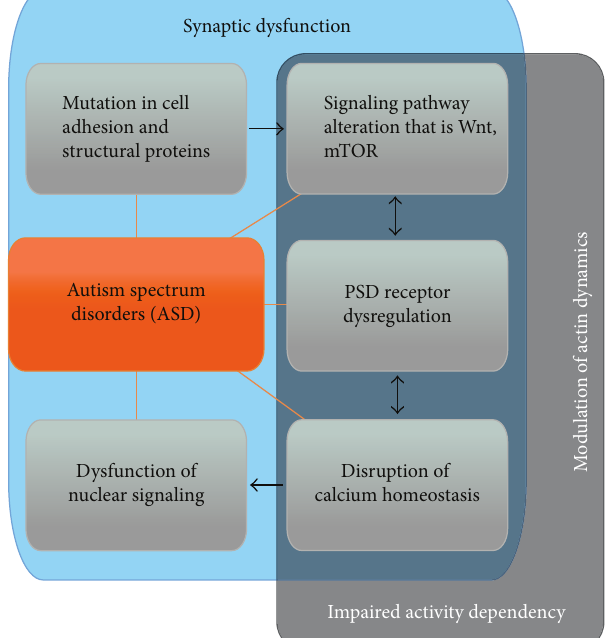
Figure6:ASDassociatedpathways.Inveryfewcases,ASDiscaused by the dysfunction of a single gene, for example, in syndromic forms of autism such as Rett syndrome (mutation in MeCP2 gene), Angelman syndrome (UBE3A gene), and fragile X syndrome (FMRP1 gene). In nonsyndromic forms, mutations in PSD adhesion molecules like neurexin and neuroligin and structural proteins like Shank are frequently found at excitatory synapses. This may lead to mGluR5 or NMDA receptor dysregulation (i.e., GRIN2A/B) and ultimately, among others, calcium homeostasis imbalance, disruption in signaling pathways like Wnt or mTOR signaling, and dysfunction of nuclear signaling. Underlying or accompanying all these alterations are impairments in action dynamics within dendritic spines.